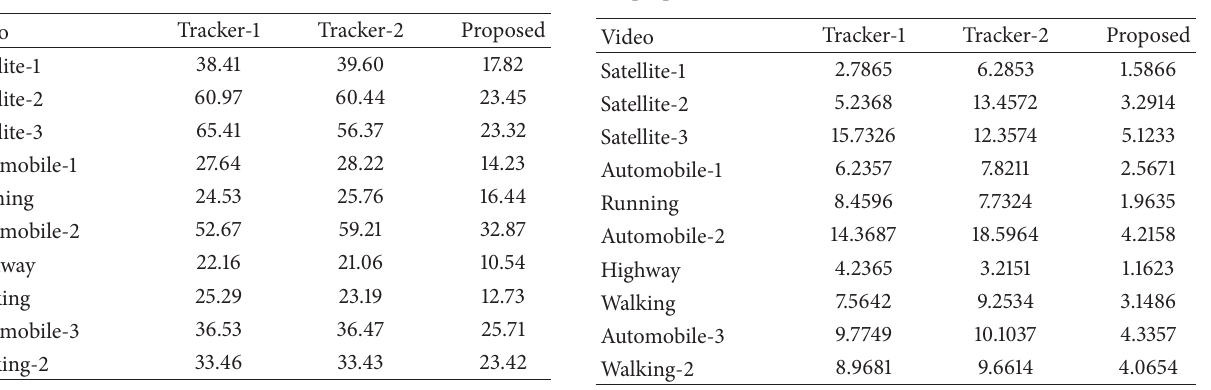
Table 2: Results of averaged MSE errors for the tracked box from our proposed method, Tracker-1 , and